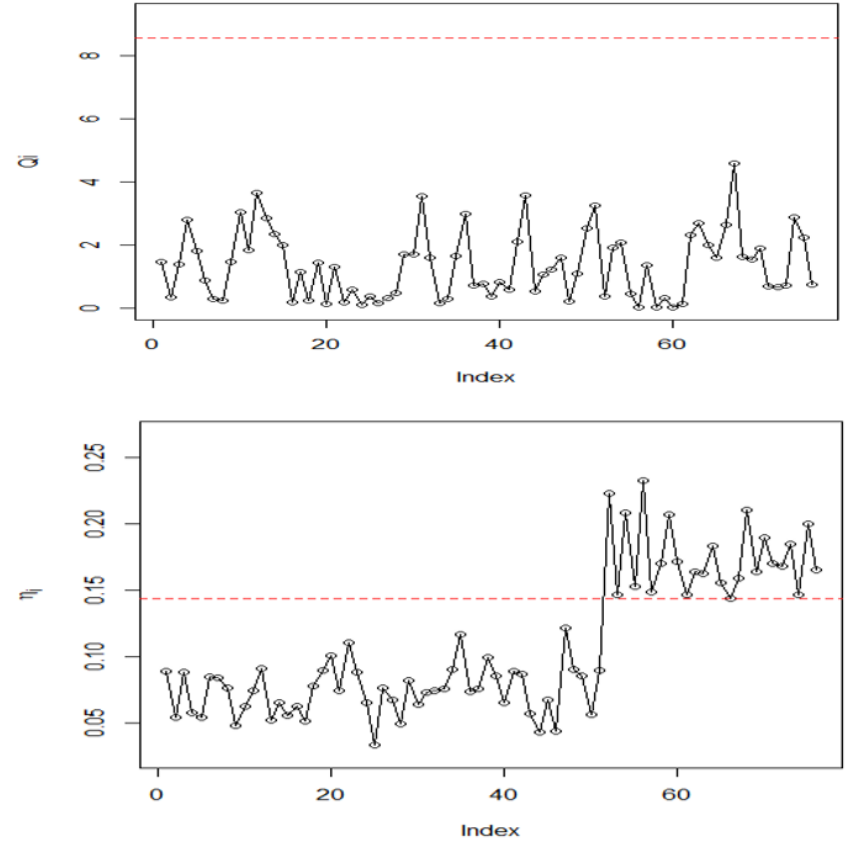
Figure 3. The MS-MAE chart for the VDP data